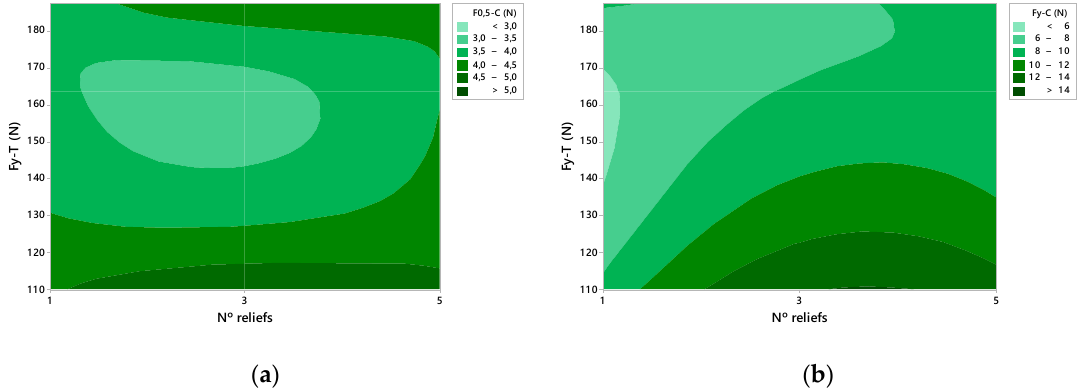
Figure 19. Graph of the compression force, F-C, in relation to the number of reliefs per face and the tensile force at the yield point, F y -T, ( a ) at the moment of displacement of 0.5 mm, F0.5-C ( b ) at the yield point, F y